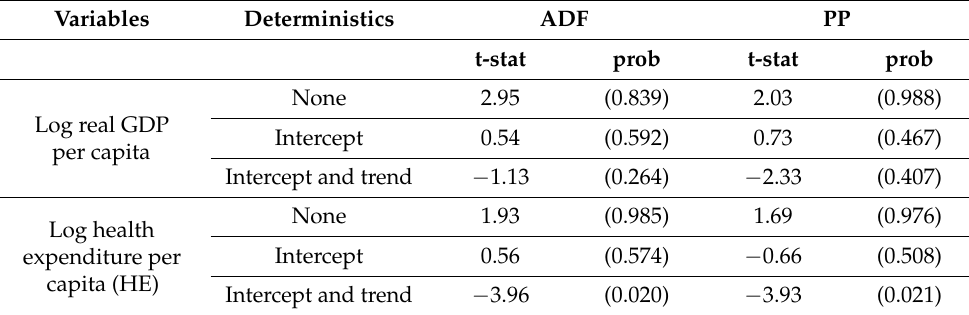
Table 4. Unit root test results.